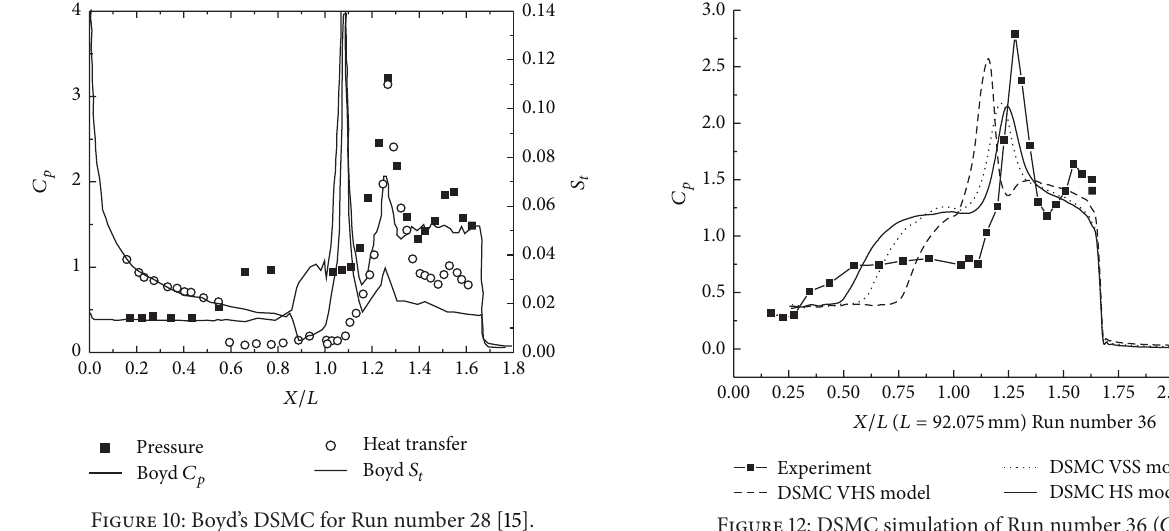
Figure 12: DSMC simulation of Run number 36 ( 𝐶 𝑃 ).